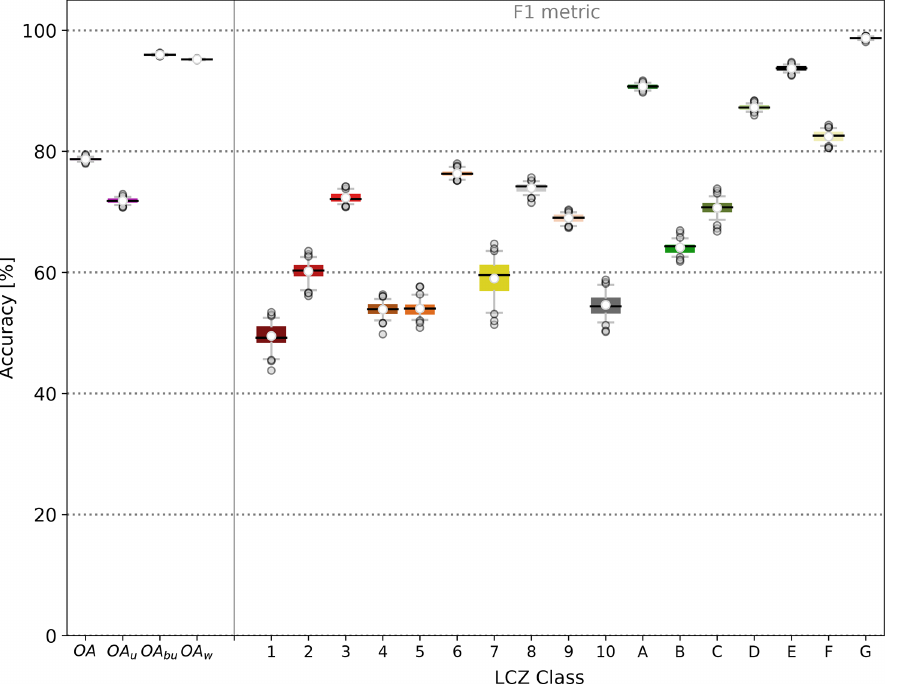
Figure G1. Overall and class-wise F1 accuracies for the global random forest LCZ models. Coloured boxes and grey whiskers span the 25th–75th and 5th–95th percentiles respectively. The means and medians are indicated by the white dots and black lines